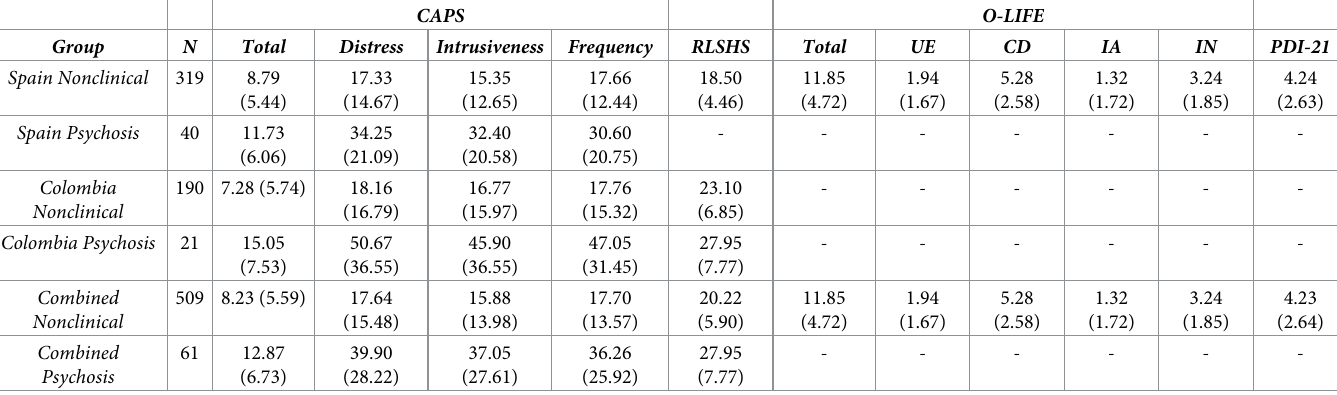
Table 1. Scale means and standard deviations for nonclinical and clinical samples in Spain and